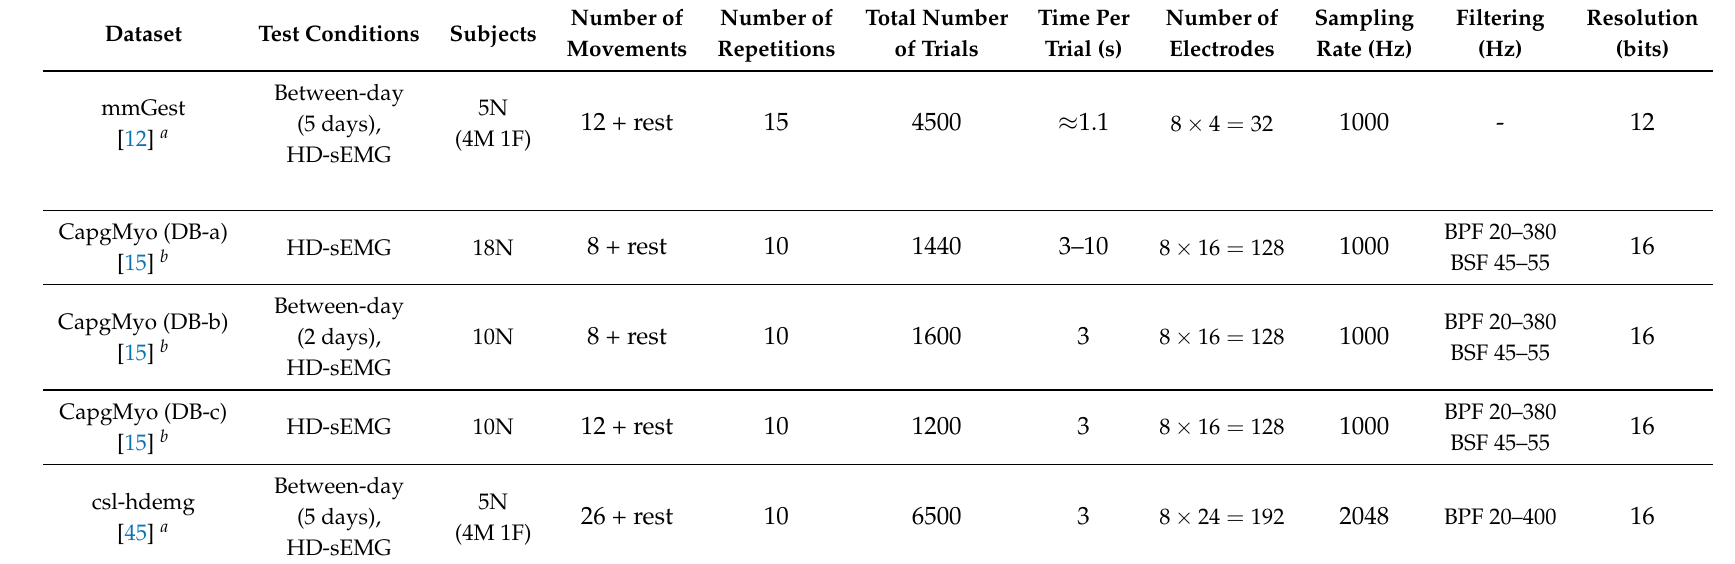
Table 3. High-density surface EMG (HD-sEMG) datasets: subject, experimental protocol, acquisition setup, and pre-processing